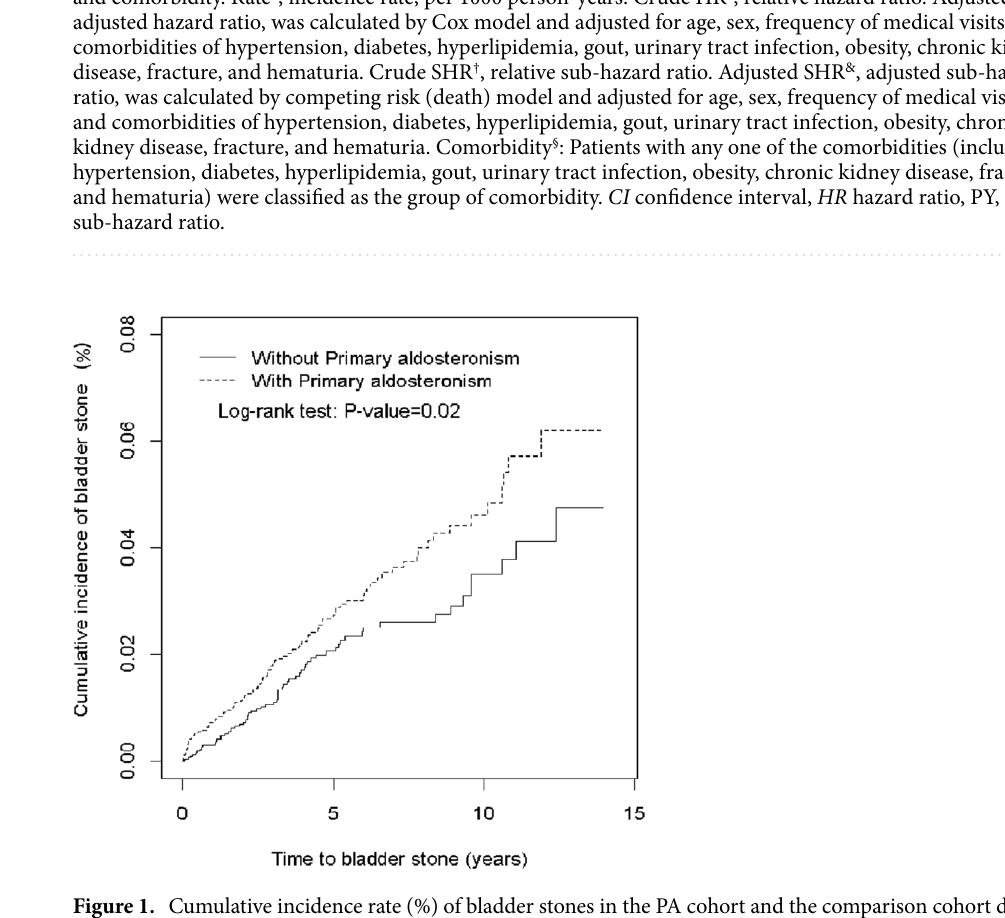
A sensitivity analysis was performed with PA versus a non-PA cohort by 1:4 frequency matching based on age, sex, and all comorbidities (Supplementary Table 1). Supplementary Table 2 demonstrated the incidence, HRs, and SHRs of bladder stones between the PA and comparison cohort. After adjusting for age, sex, and comorbidities, the HR of bladder stones was 1.63 (95% CI 1.28–2.08) for patients with PA compared to individuals without PA. In this sensitivity analysis, outcome was also consistent with the primary analysis.